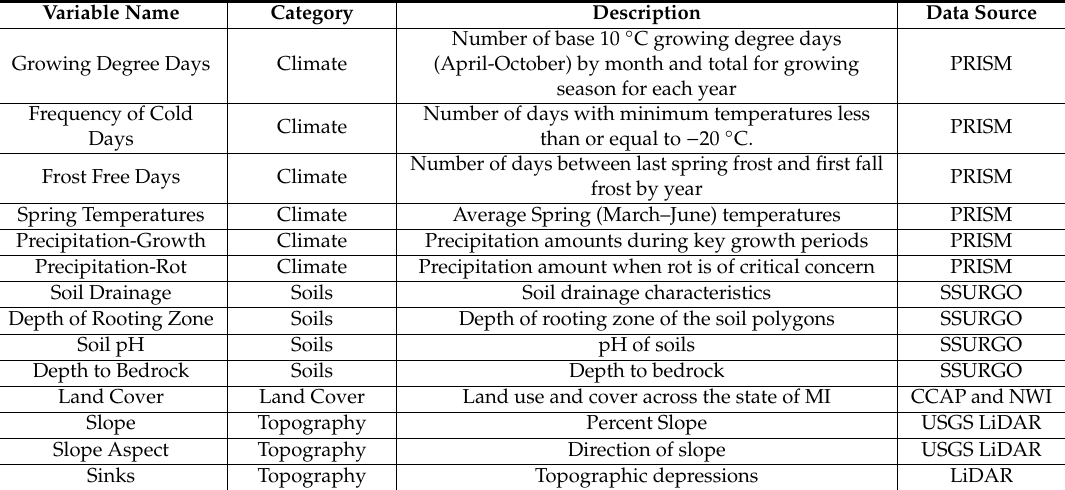
Figure 1. Locations of 17 counties across the state of MI used in the study. Traditional counties with current or past vinifera production are highlighted in dark green. Other project counties have little or no current vinifera cultivation (light green). Table 1. Descriptions and sources of data used in this